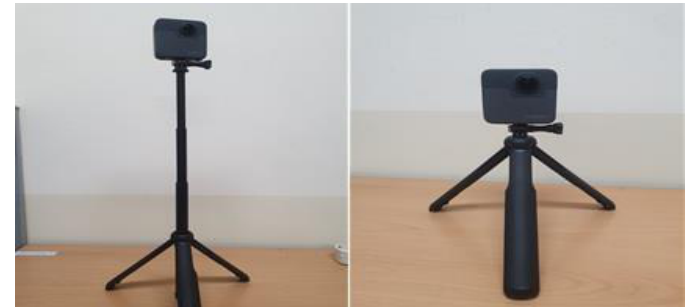
Figure 2. The 360°